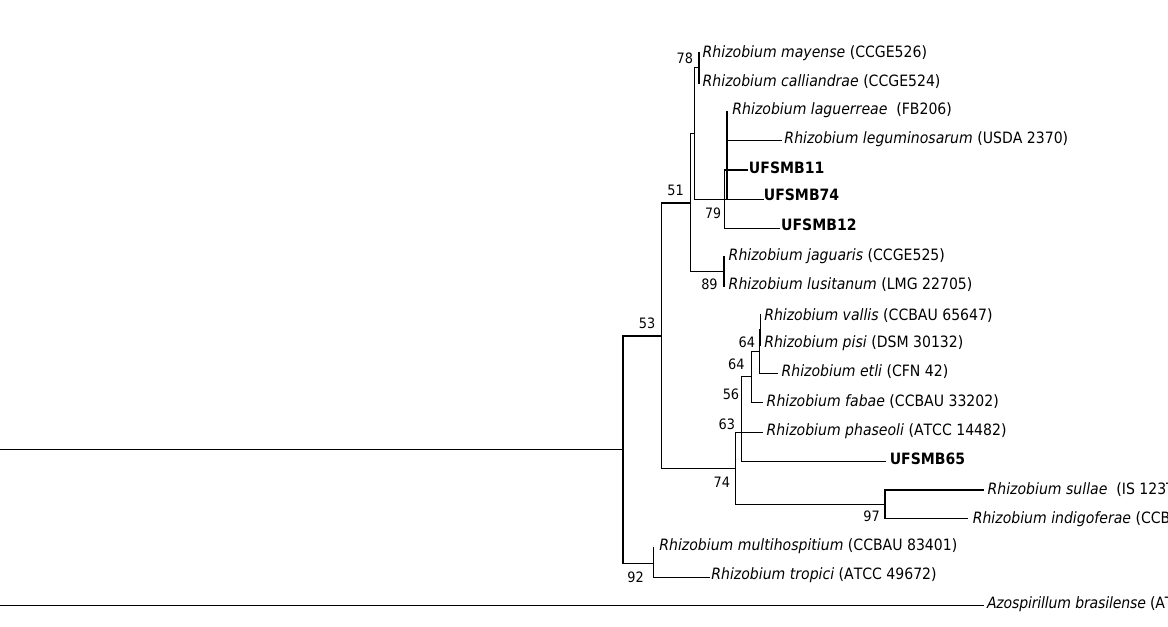
Figure 4. Phylogenetic tree based on 16S rRNA gene sequence similarity of Bradyrhizobium strains. The phylogenetic tree was built using neighbor-joining and Kimura 2-parameters (K2P). Numbers on branches indicate bootstrap values, with a total of 1000 replicates; only values greater than 50 are shown. Bar indicates 2 substitutions per 100